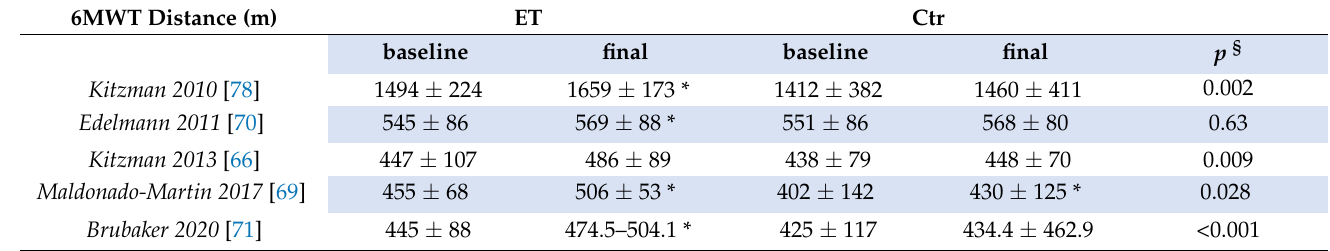
Table 4. Results of trials investigating the effects on 6-minute walking distance of exercise training in